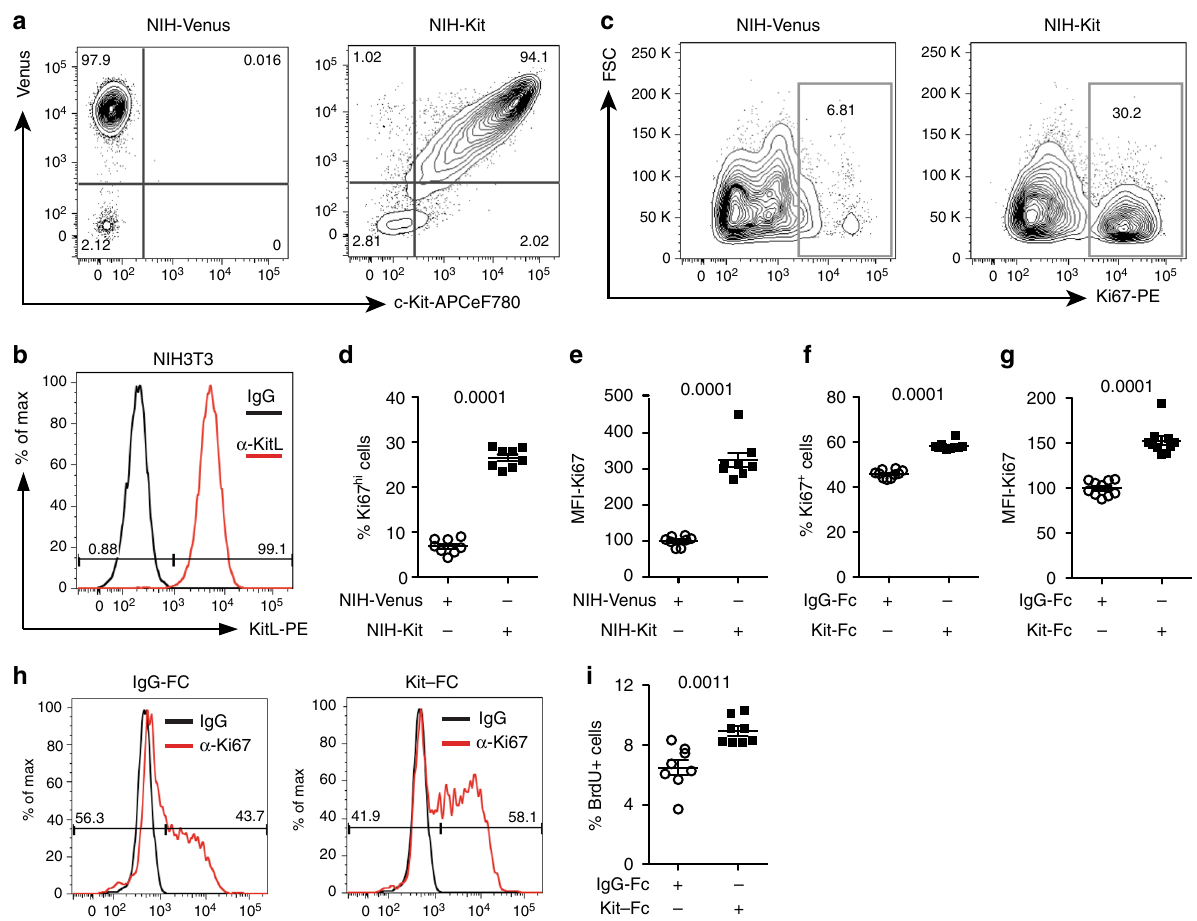
Fig. 1 Membrane-bound Kit ligand acts as a c-Kit receptor to induce cell proliferation. a Flow cytometry plots of pRRL-Venus-transduced (left plot; NIH- Venus) and pRRL – c-Kit-Venus-transduced NIH3T3 cells (right plot; NIH-Kit) stained with anti – c-Kit antibody. Data are representative of three experiments. b Flow cytometry plot of NIH3T3 cells stained with anti-SCF antibody or control IgG, as indicated. Data are representative of three experiments. c Ki67 expression in NIH3T3 co-cultured together with NIH-Venus (left plot) or NIH-Kit (right plot) detected by intracellular fl ow cytometry. Gating shows Ki67 high cells. d Percentage of Ki67 high cells in cultures from c ( N = 7, two experiments). Bars show mean ± s.e.m. P -value is shown (Student ’ s t -test). e Mean fl uorescence intensity (MFI) of Ki67 signal in samples from d . Bars show mean ± s.e.m., with NIH-Venus mean = 100. P -value is shown (Student ’ s t -test). f Percentage of Ki67 + cells in cultures from NIH3T3 treated with 200 ng/ml Kit-Fc ( N = 10; two experiments) or IgG-Fc ( N = 10, two experiments), as indicated, for 24 h prior to analysis by intracellular fl ow cytometry. Bars show mean ± s.e.m., with NIH-Venus mean = 100. P - value is shown (Student ’ s t -test). g Mean fl uorescence intensity (MFI) of Ki67 signal in NIH3T3 cells from f . Bars show mean ± s.e.m., with NIH-Venus mean = 100. P -value is shown (Student ’ s t -test). h Representative fl ow cytometric analysis of Ki67 expression in IgG-Fc (left panel) and Kit-Fc (right panel) treated NIH3T3 cells from f . i Percentage of NIH3T3 cells incorporating BrdU after 8 h treatment with 200 ng/ml IgG-Fc or Kit-Fc ( N = 8; two experiments) as indicated. BrdU was added to the culture medium 2 h before analysis. Bars show mean ± s.e.m. P -value is shown (Student ’ s t